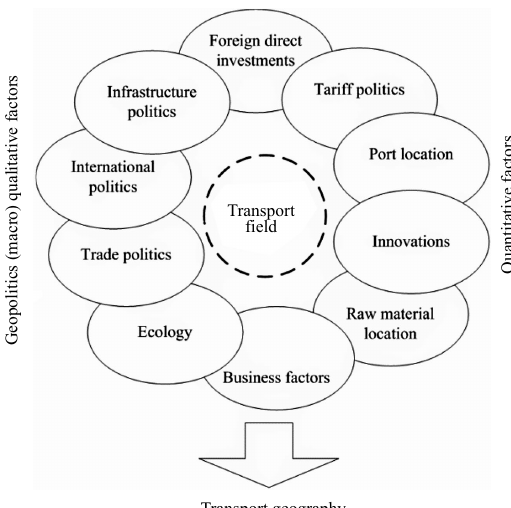
Transport Fig. 2. Conceptual relation between factors influencing the analysis of a field of transportation (Brodin 2003)